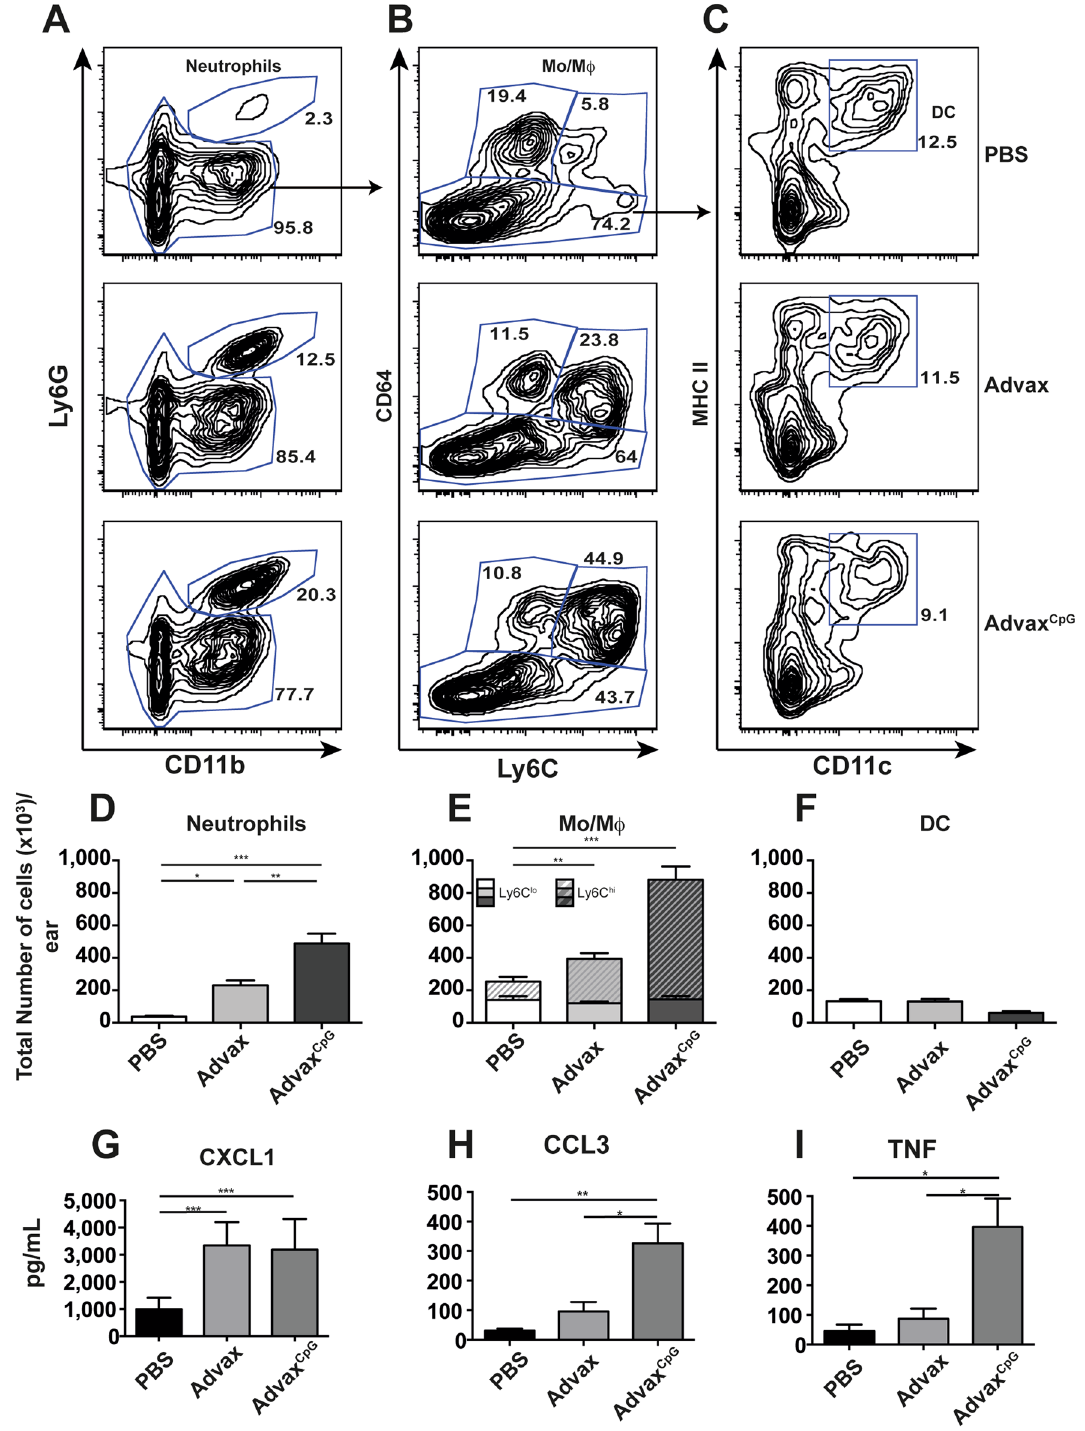
Figure 4. Advax-mediated leucocyte recruitment at the site of vaccination. C57BL/6 mice (n = 4) were injected i.d. in the ear with PBS, Advax or Advax CpG . Ears were harvested 48 hrs later and cell composition determined by flow cytometry. ( A ) Representative plots showing the gating strategy to select single live immune cells. Subsequent hierarchical gates were used to identify neutrophils (Ly6G + CD11b + ), monocyte/macrophage (Mo/M φ ) populations (CD64 + Ly6G lo/hi ), and dendritic cells (DC; CD11c + MHCII hi ), with the total number of each respective cell population shown in panels D, E and F. Supernatants from isolated cells were analysed by cytokine beads array for the secretion of CXCL1 ( G ), CCL3 ( H ) or TNF ( I ). Data (average ± SEM) is representative of two independent experiments. Statistical significance between groups was determined by ANOVA ( * p < 0.05; ** p < 0.01, *** p <